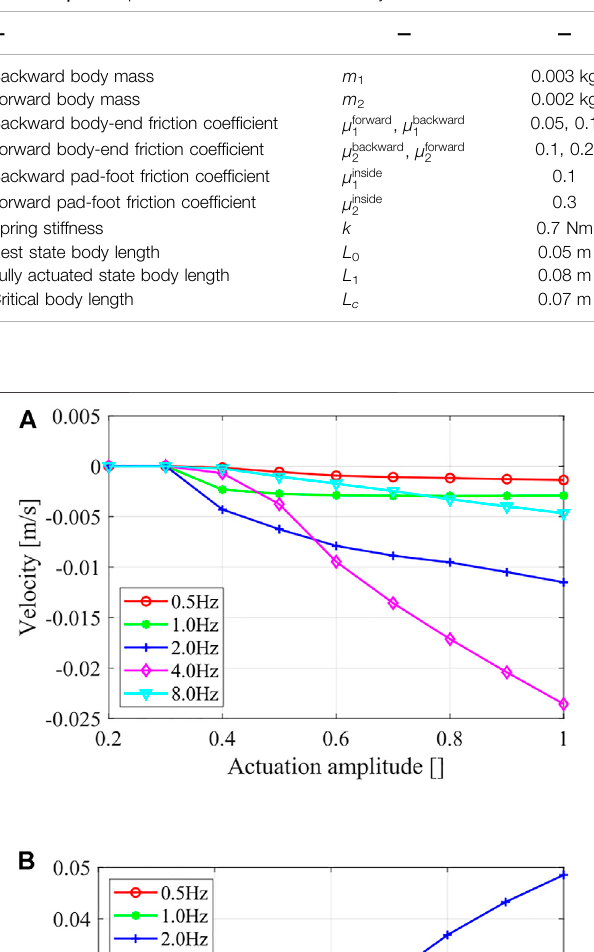
TABLE 1 | Robot parameters in the simulation study.